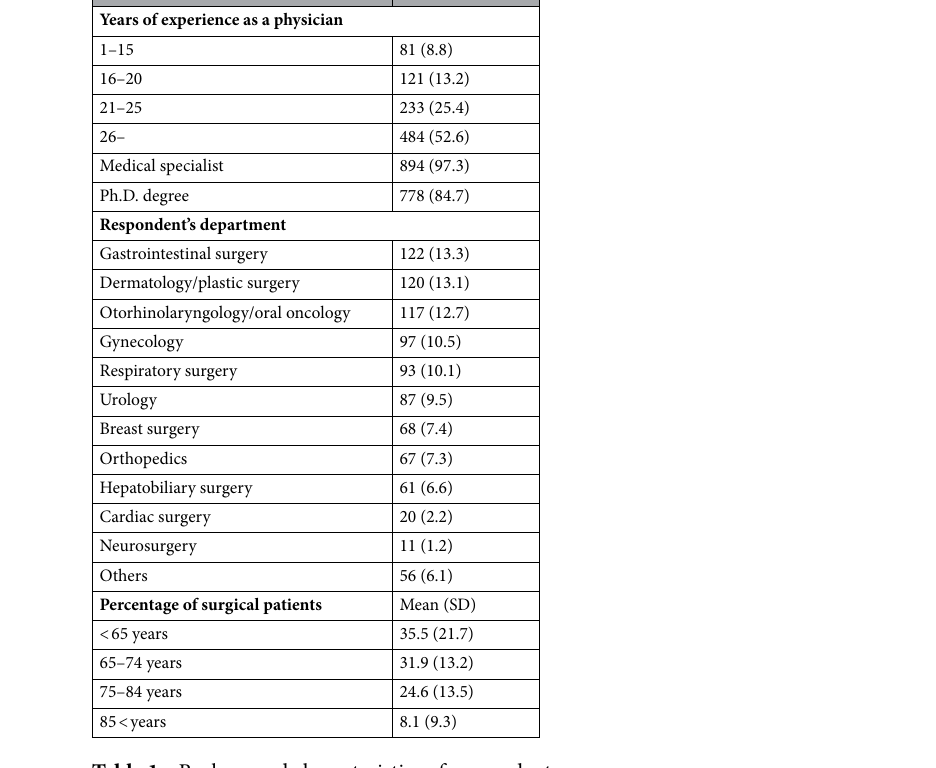
Table 1. Background characteristics of